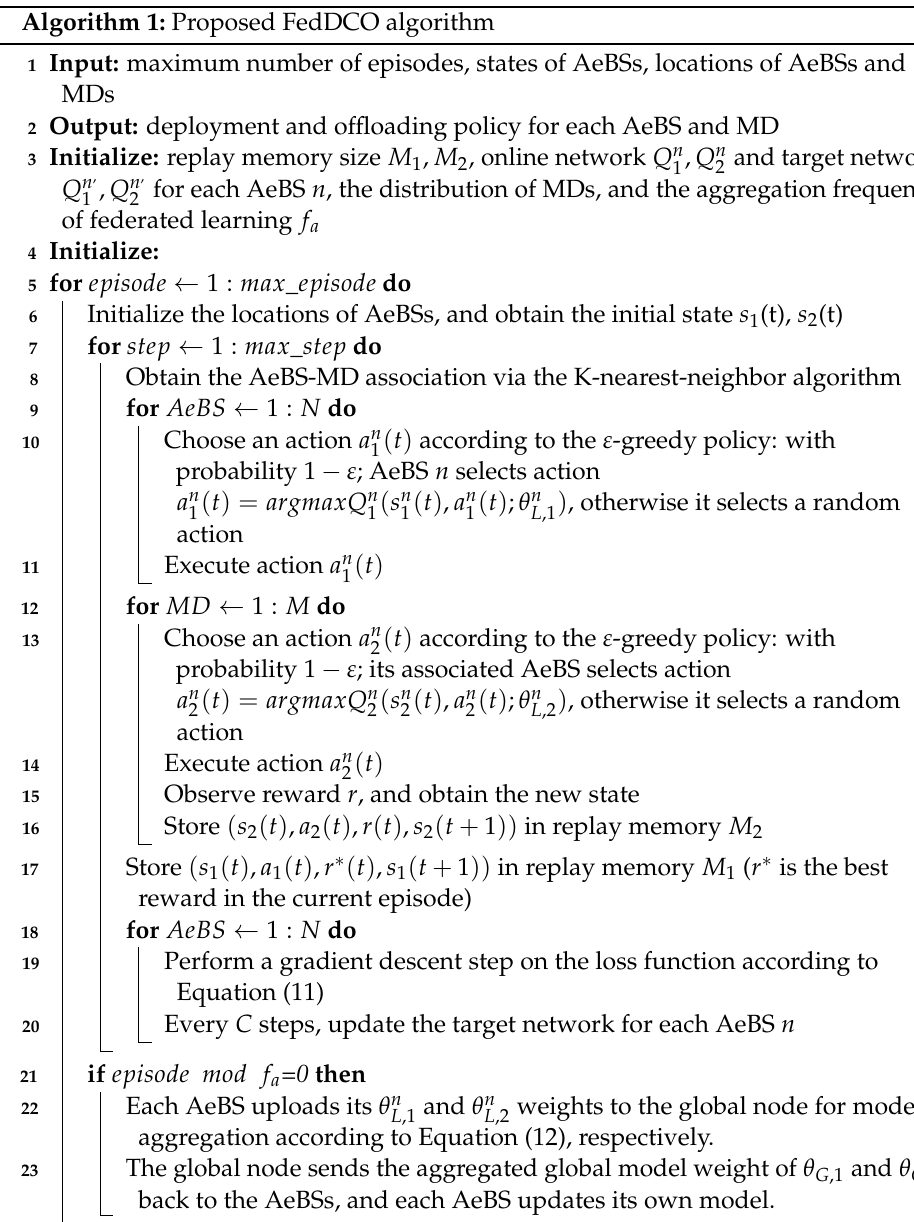
Algorithm 1: Proposed FedDCO